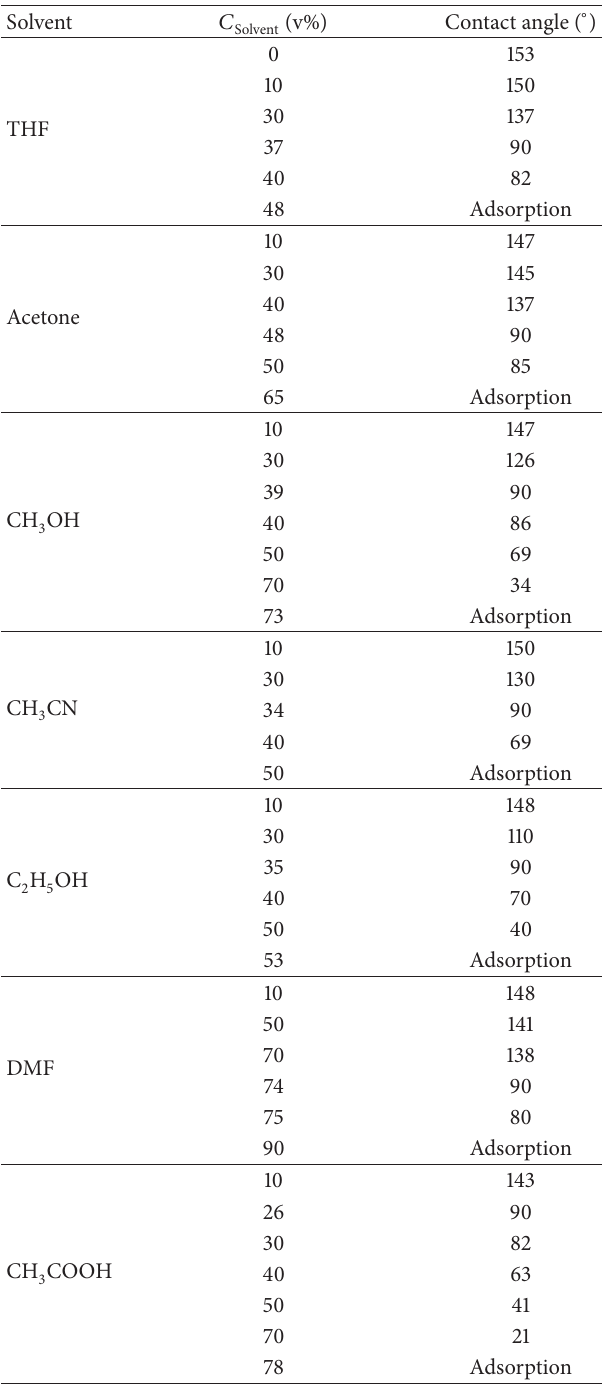
Table 2: Contact angle measurements for silica aerogel with different solvents in water.